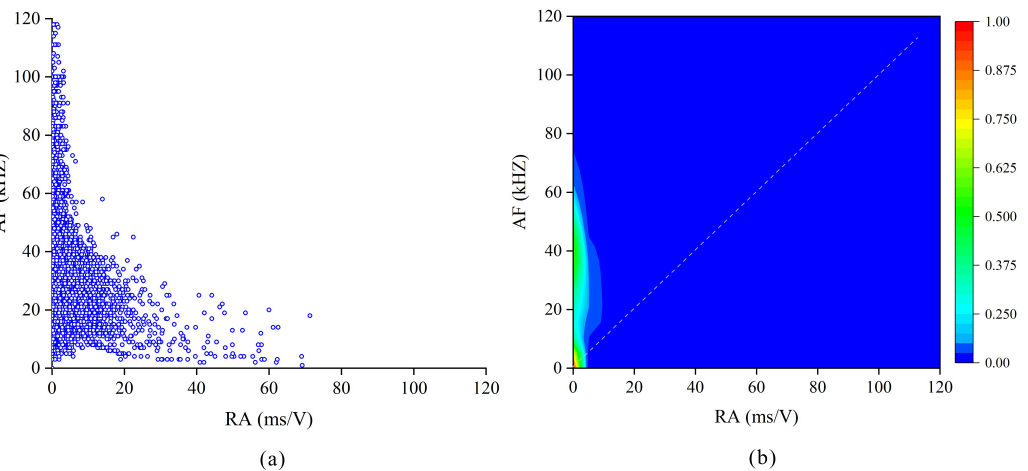
Figure 13. Distribution of the AE RA ‐ AF parameters for the specimen with a brittleness index of 2.25: ( a ) scatter diagram; and ( b ) density nephogram.